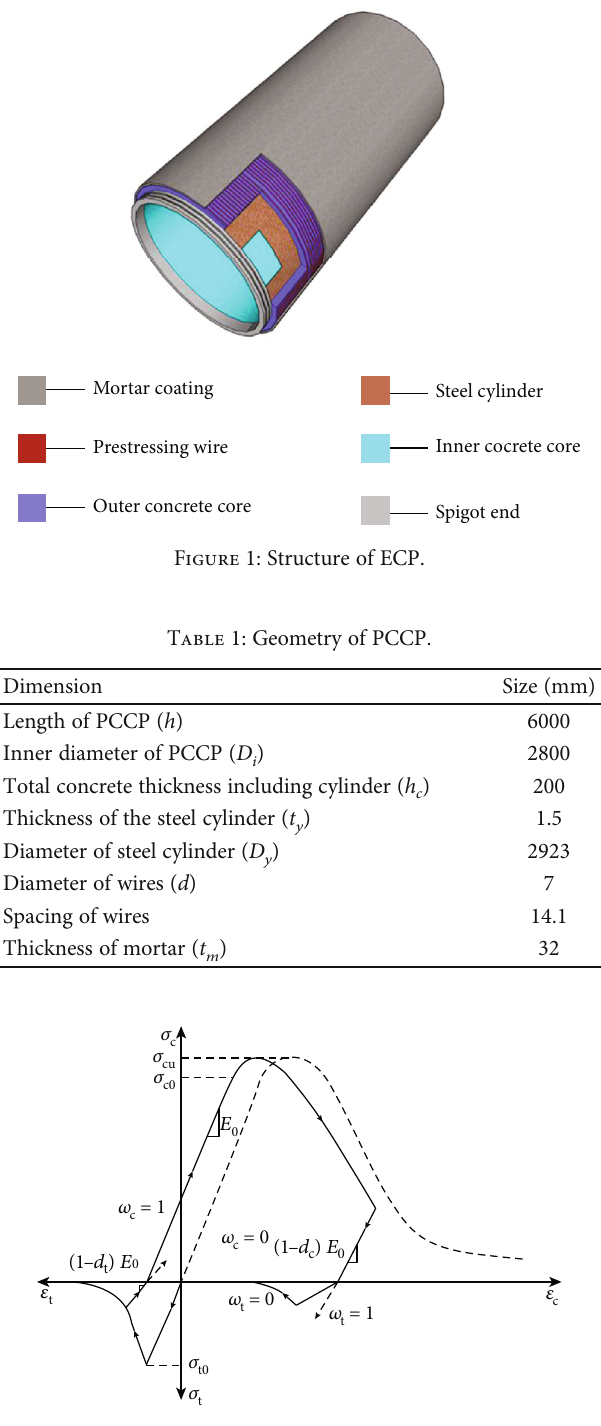
Figure 2: ABAQUS concrete damaged plasticity